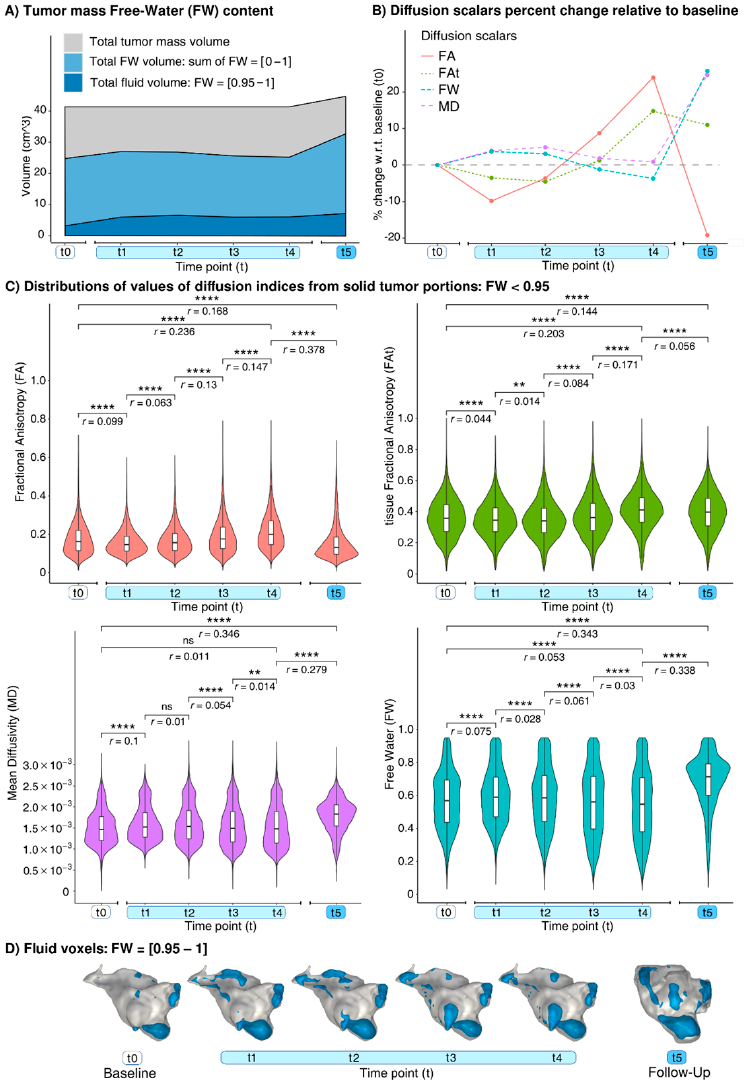
Figure 2. Longitudinal effects from baseline (t0) and at t1 = 9, t2 = 17, t3 = 24, and t4 = 30 days after PBT treatment start. ( A ) Volumes of tumor mass (grey), overall FW (light blue), fluid voxels (dark blue). ( B ) Percent changes with respect to t0 of tumor solid voxels median values and ( C ) their distributions. ( D ) Mapping of fluid voxels (blue) on tumor 3D renders (grey). Note: ns: not significant, **: p < 0.01, ****: p < 0.0001. The p -values were Bonferroni corrected for longitudinal comparisons and the four diffusion